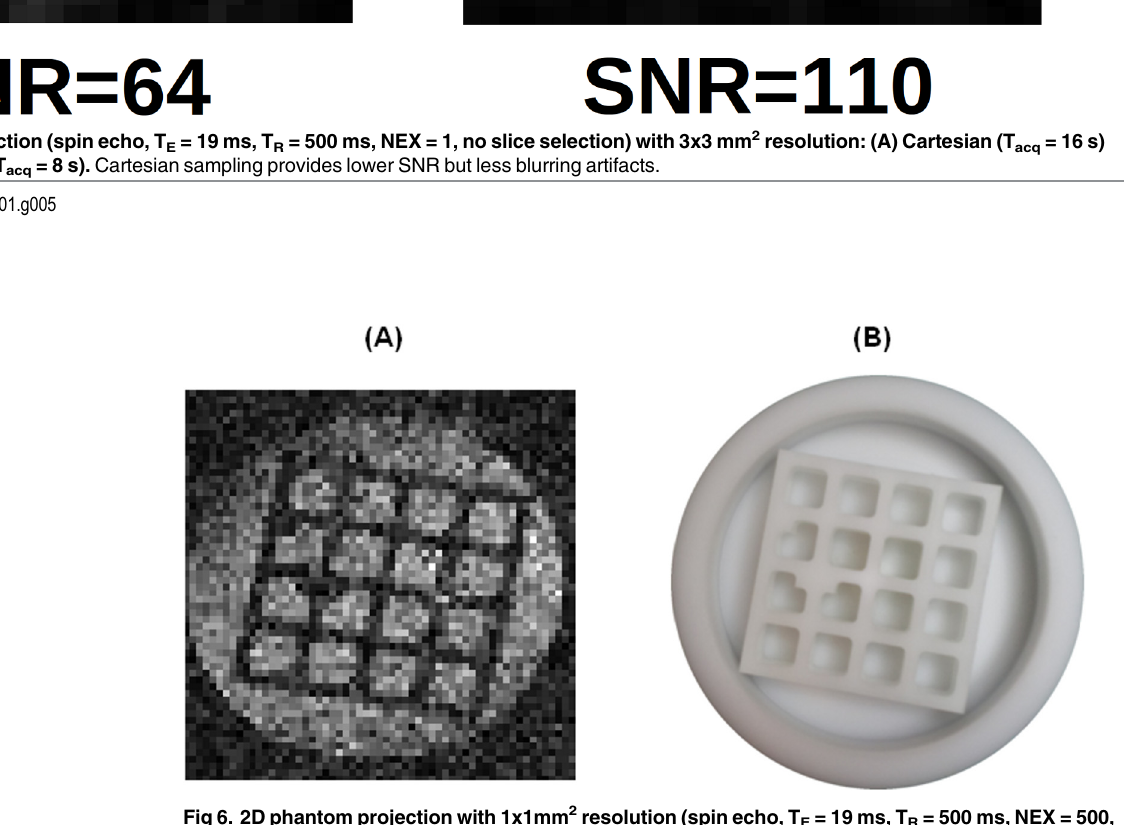
Fig 6. 2D phantom projection with 1x1mm 2 resolution (spin echo, T E = 19 ms, T R = 500 ms, NEX = 500, no slice selection, T acq = 2.2 h) of the linearity phantom (a) and a picture of it (b). There is no evidence of spatial distortions due to concomitant gradient effects.